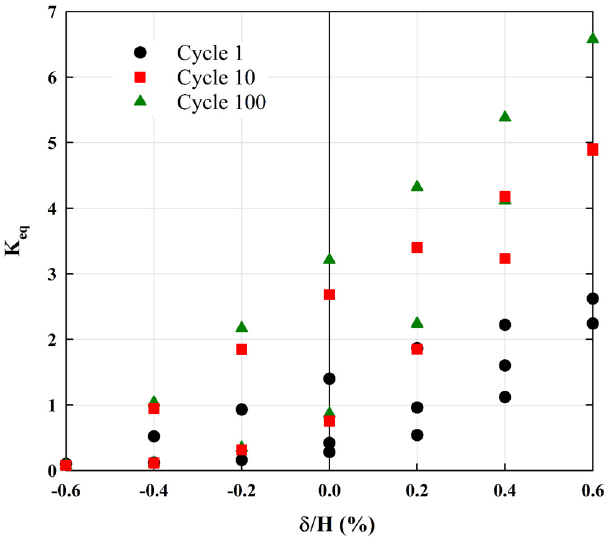
Figure 11. Variation of the equivalent lateral earth pressure coefficient ( K eq ) during cycles 1, 10 and 100.